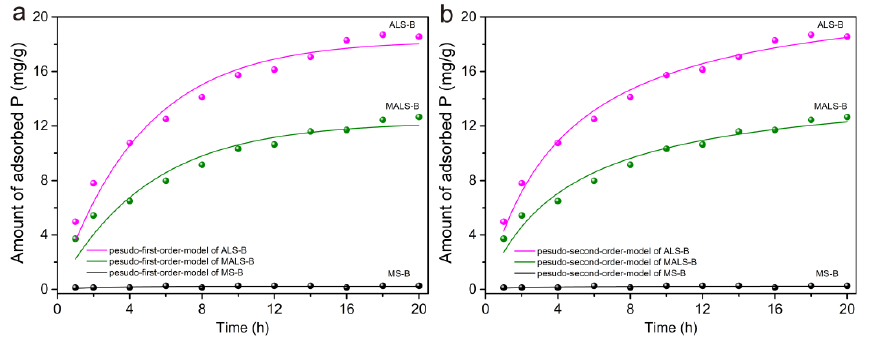
Figure 5. Phosphate adsorption kinetics of the synthesized hydrogel beads with results fitted to the ( a ) pseudo-first-order and ( b ) pseudo-second-order models. ( a ) pseudo-first-order and ( b ) pseudo-second-order